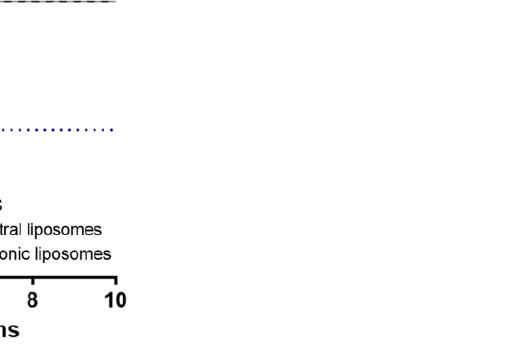
Figure 2. Effect of the repeated administration of PBS, neutral and cationic liposomes on mice sur- vival.